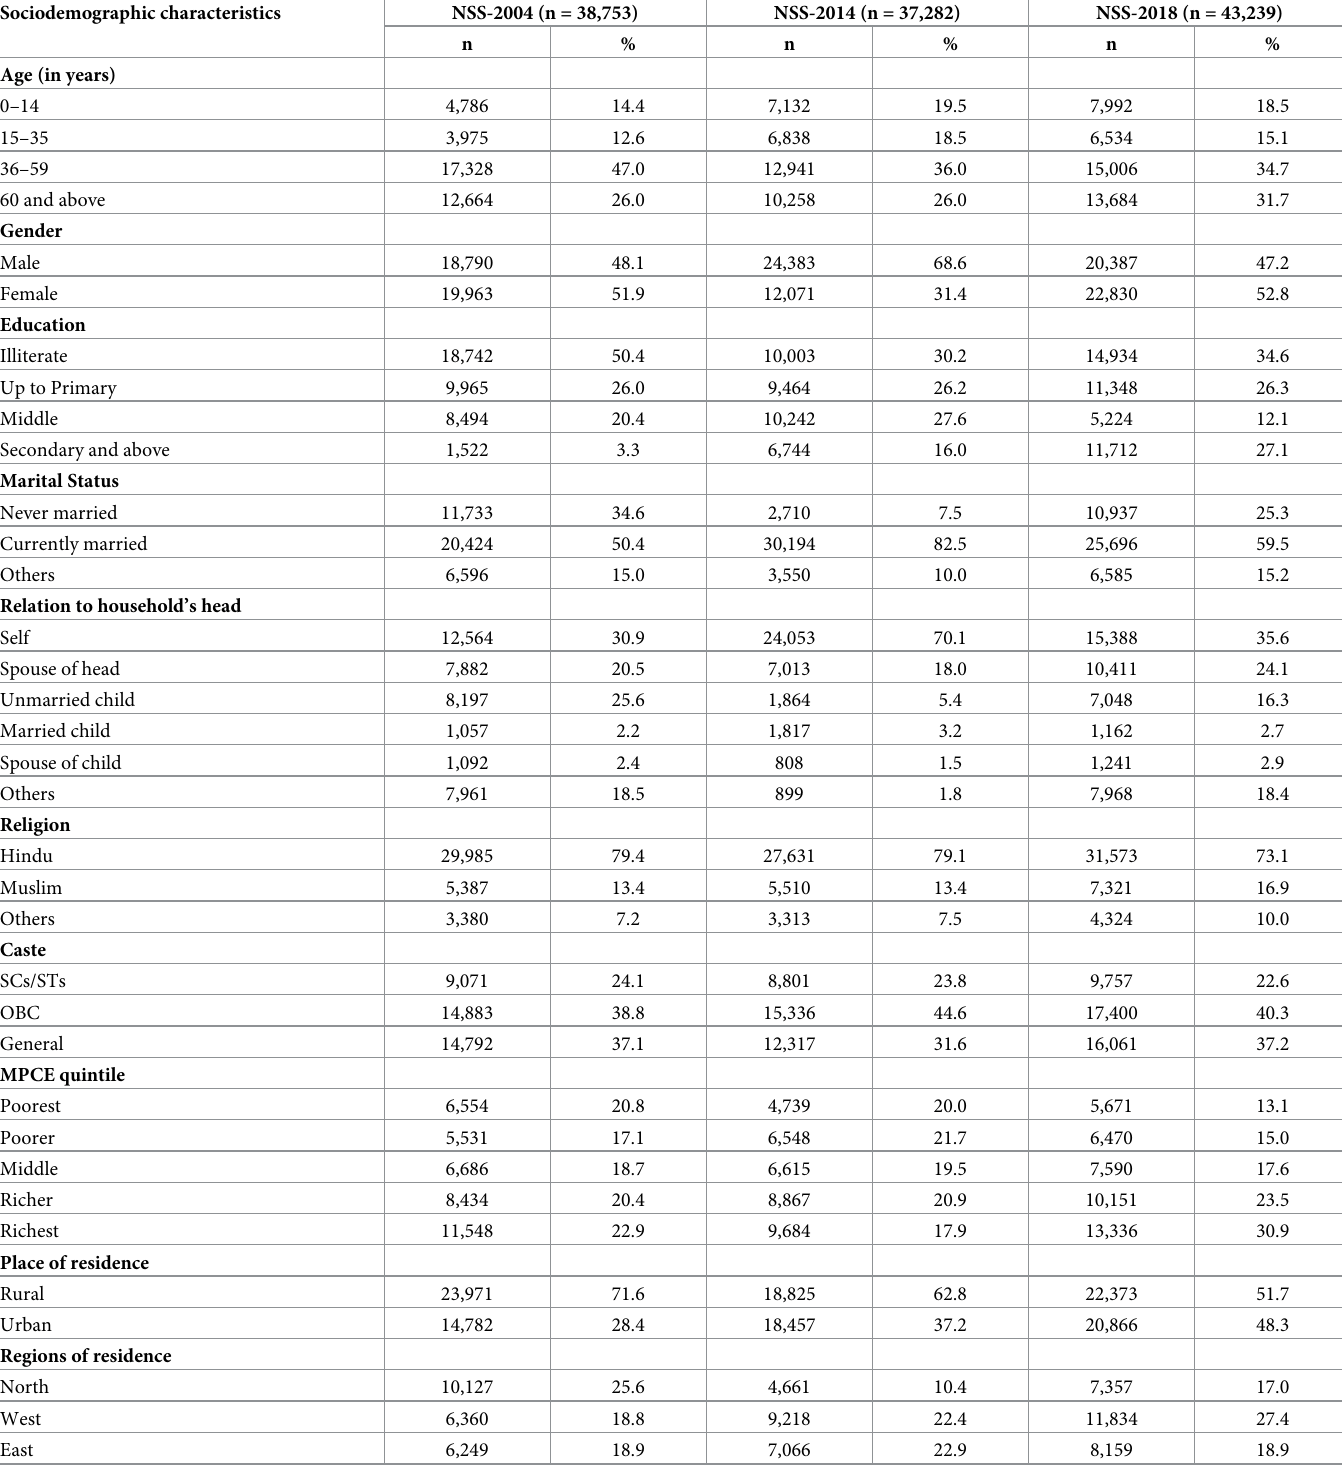
Table 1. Profile of individuals who have suffered/are suffering from any disease in 15 days prior to the survey date by sociodemographic characteristics in India, NSS, 2004–2018. Sociodemographic